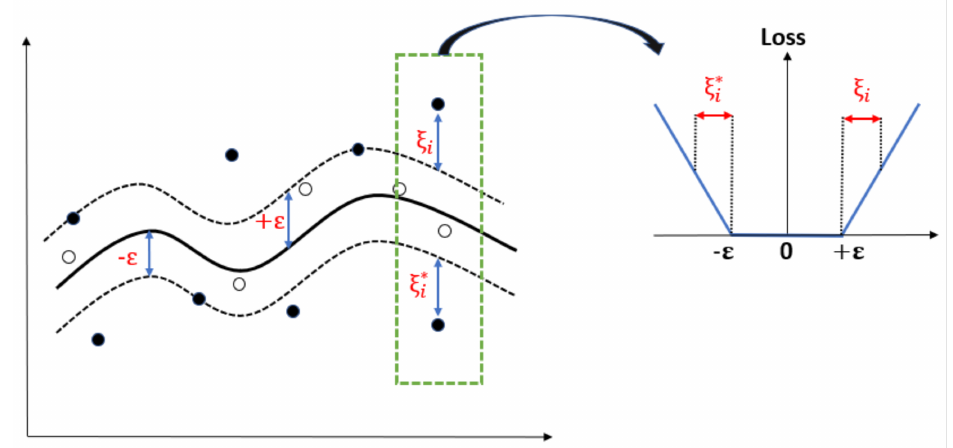
Figure 1. Loss Setting for Nonlinear SVR. The right side of the image shows soft ε -insensitive setting as described in [11] for SVR. Any values between − ε and + ε are assigned a loss 0 and values outside the range is assigned a loss of | ξ | − ε